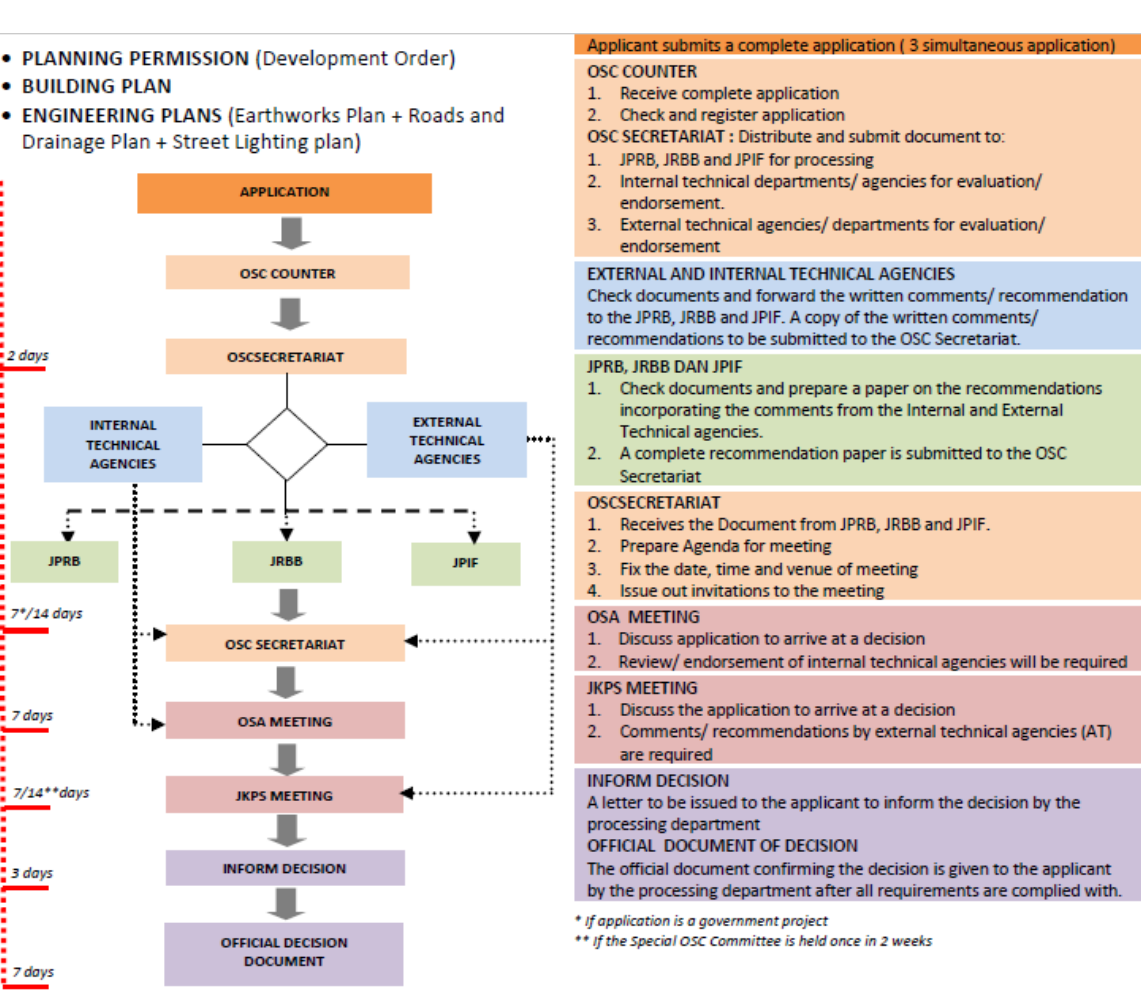
Figure 7: Small scale planning approval